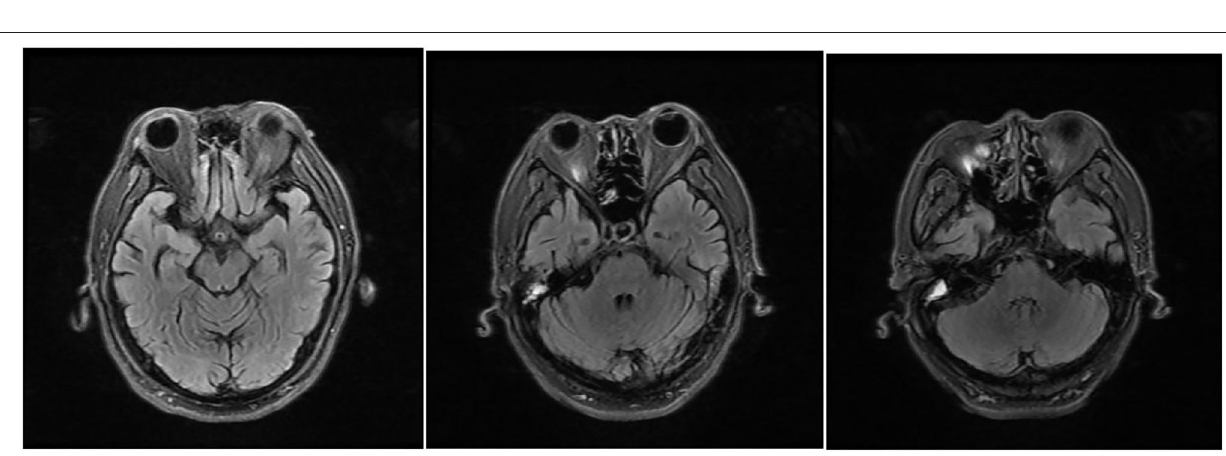
FIGURE 3 | MRI reexamination of the patient after drug withdrawal during his second time in the hospital, T2/fluid-attenuated inversion recovery (FLAIR) showing abnormally high signals around the midbrain aqueduct, around the fourth ventricle, and in the dentate nuclei of the cerebellum bilaterally, which disappeared 9 days after drug